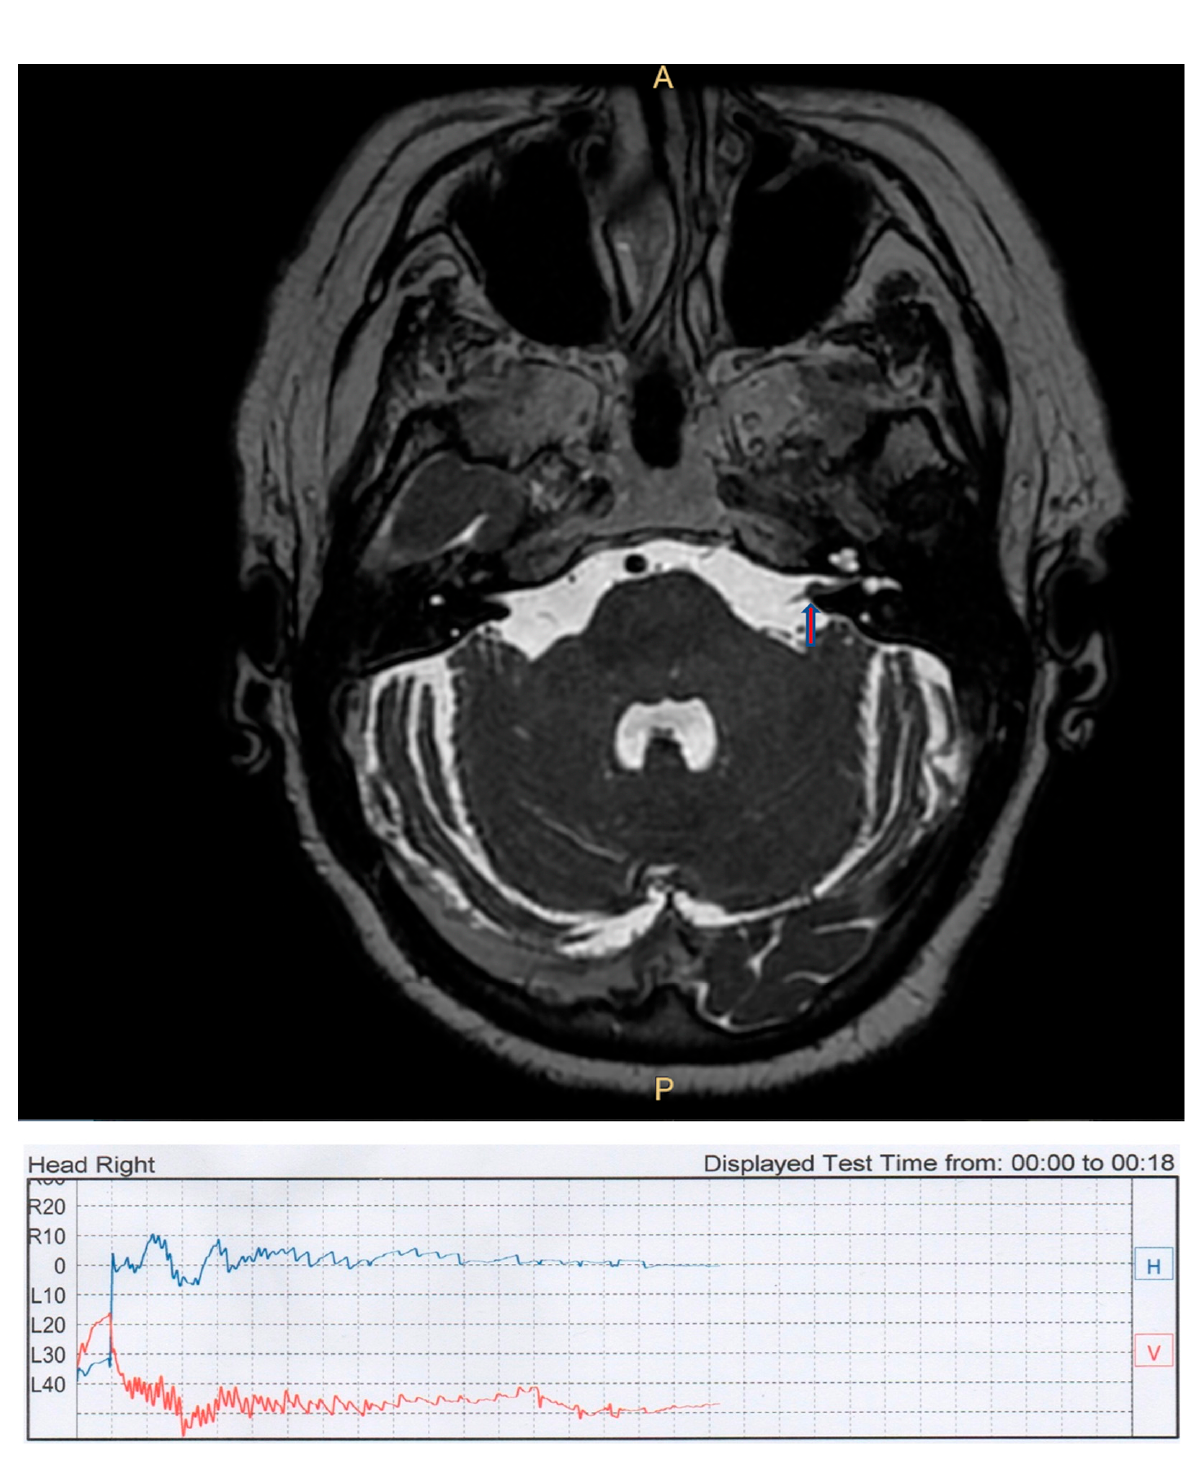
Figure 1. Case TL. ( Top ): brain axial T2 cube MRI with a left-side intrameatal AN (arrow). ( Bottom ): videonistagmographic recording of contralateral PSC BPPV.